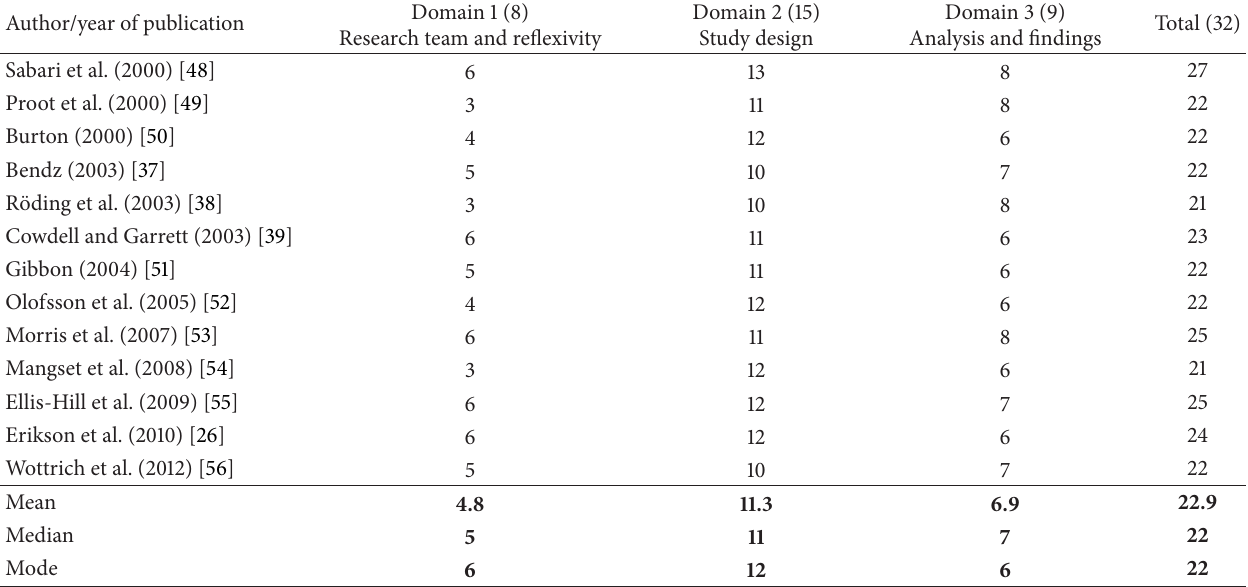
Table 3: The summary of results of the COREQ (Tong et al., 2007 [62]) appraisal for the thirteen included